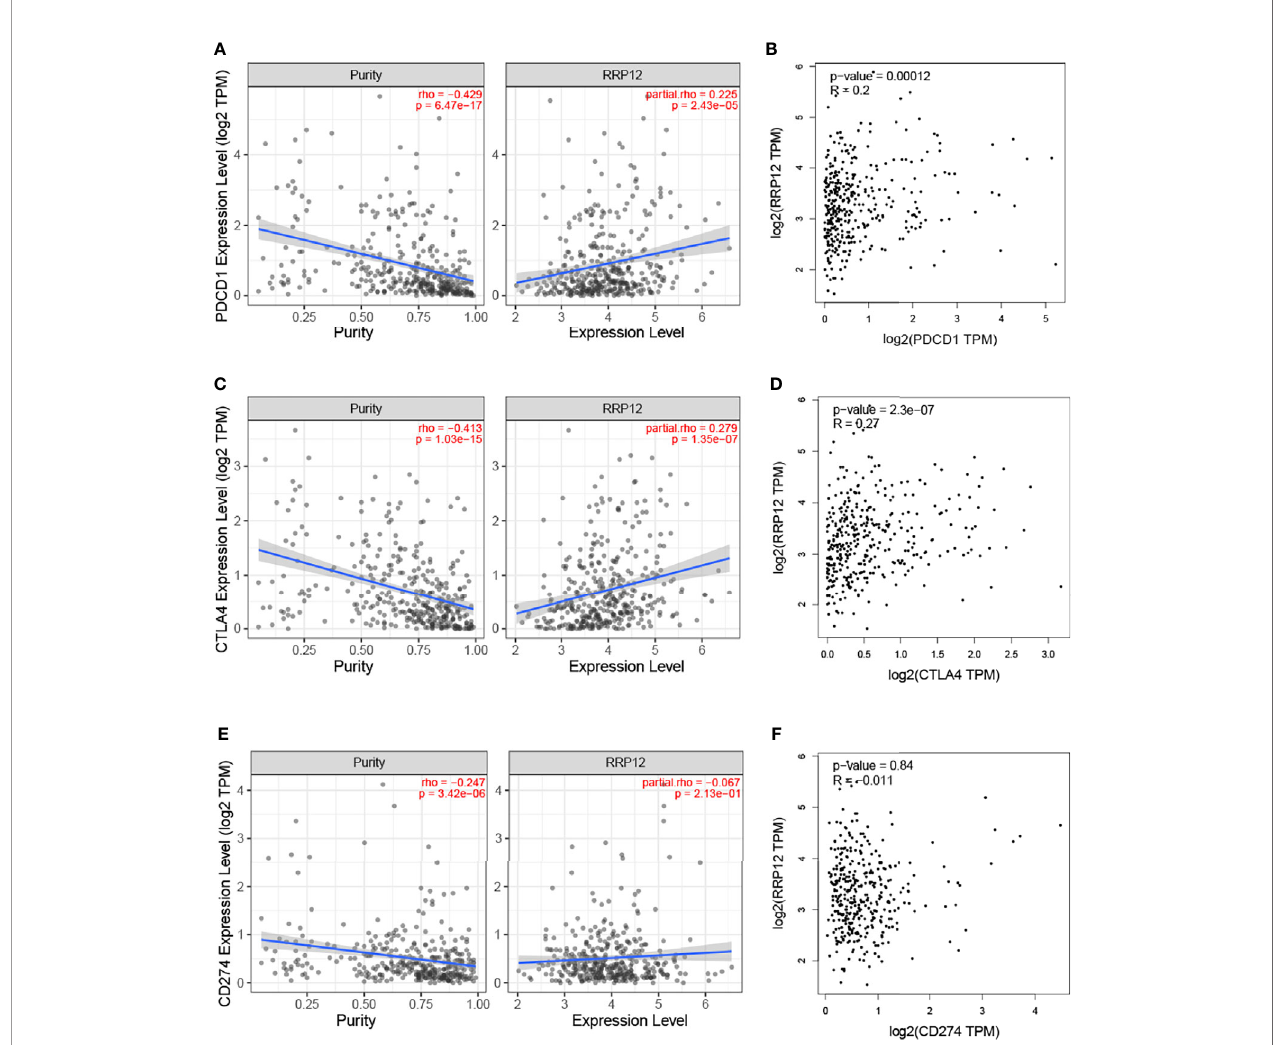
FIGURE 7 | Correlation of RRP12 expression with PD-1, PD-L1, and CTLA-4 expression in HCC. (A) Spearman correlation of RRP12 with expression of PD-1 in HCC adjusted by purity using TIMER. (C) Spearman correlation of RRP12 with expression of CTLA-4 in HCC adjusted by purity using TIMER. (E) Spearman correlation of RRP12 with expression of PD-L1 in HCC adjusted by purity using TIMER. (B) The expression correlation of RRP12 with PD1 in HCC determined by GEPIA database. (D) The expression correlation of RRP12 with CTLA-4 in HCC determined by GEPIA database. (F) The expression correlation of RRP12 with PD-L1 in HCC determined by GEPIA